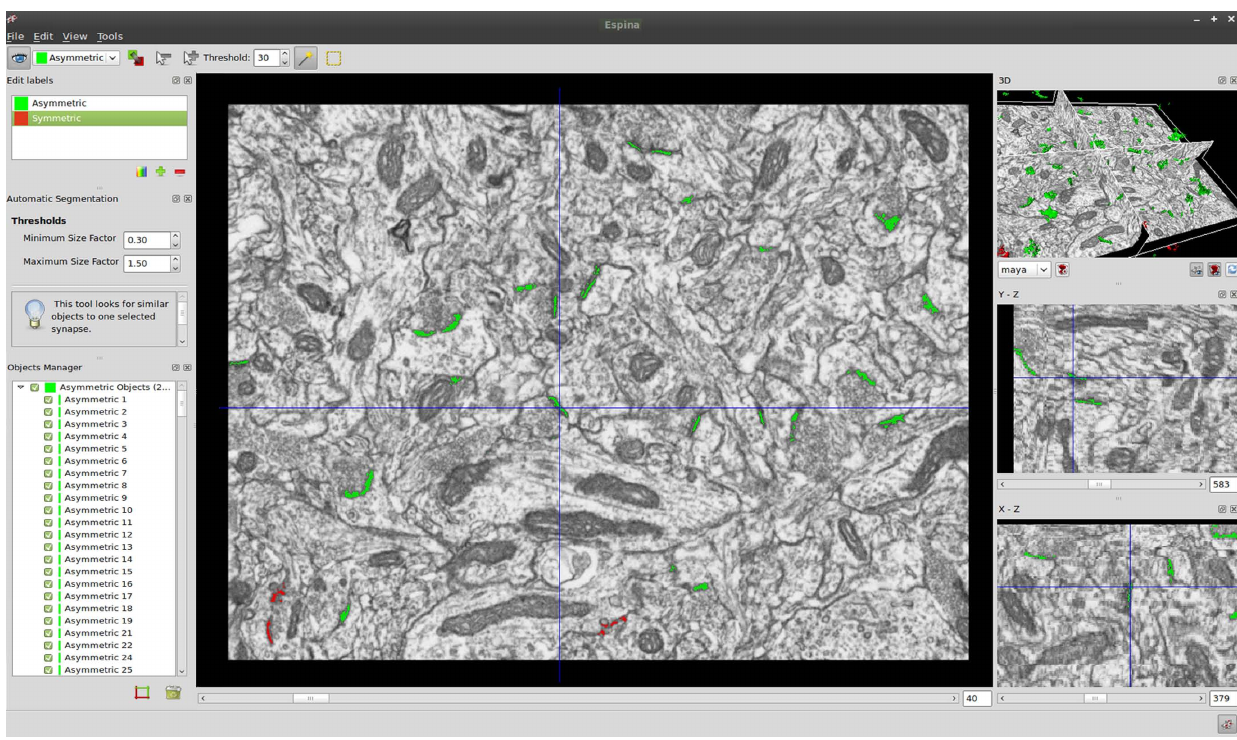
Figure 2 | Screenshot of the user interface showing the main window and the three additional auxiliary windows. In the main window the sections are viewed through the x–y plane, as they were obtained by FIB/SEM microscopy. The other two orthogonal planes, y–z and x–z , are also shown in their respective windows. The 3D window shows the three orthogonal planes and the 3D reconstruction of the segmented objects. The location of the mouse pointer is